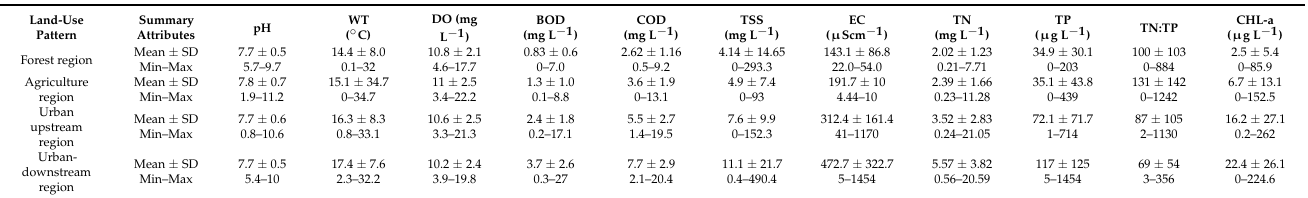
Table 1. Summary statistics of selected water chemistry variables in the forest, agriculture, urban upstream, and urban downstream regions during the study period